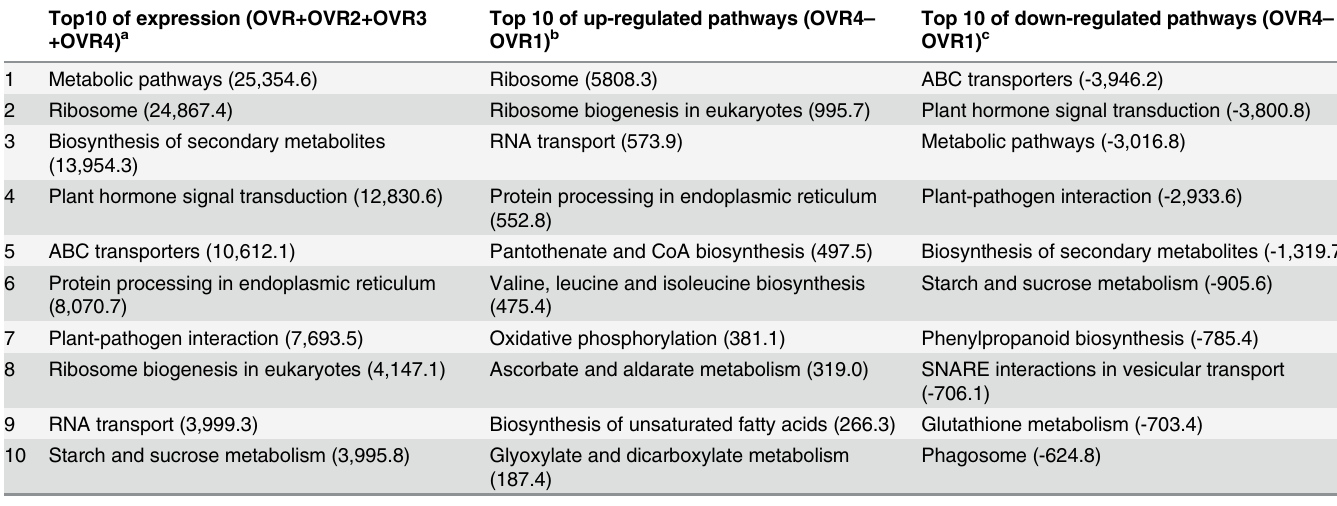
Table 3. The summary of KEGG pathways with the significantly change of gene expression in ovule development. Top10 of expression (OVR+OVR2+OVR3 +OVR4) a